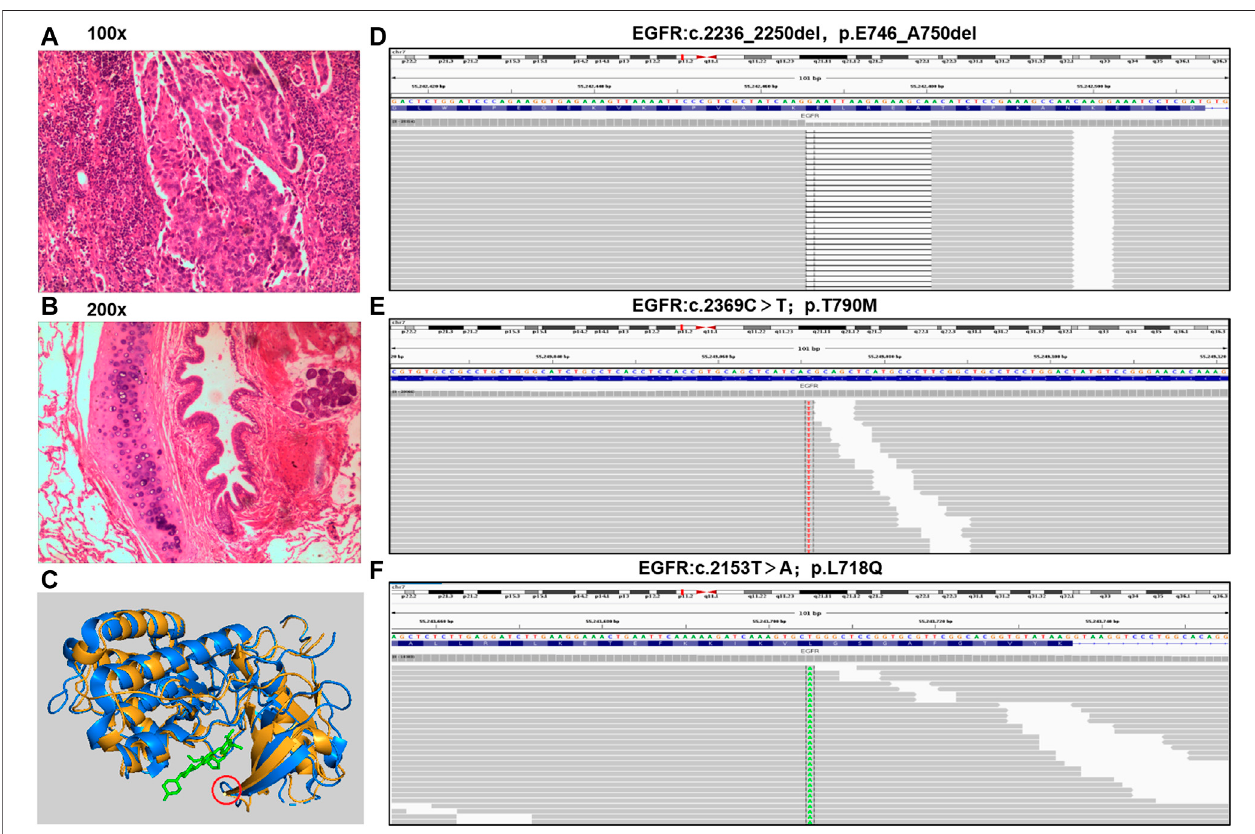
FIGURE 1 | Pathological diagnosis and molecular diagnosis. (A,B) , tumor specimen was applied to apex of right lung with a pathological diagnosis of lung adenocarcinoma(hematoxylin-eosinstaining:100xand 200x). (C) ,Three-dimensionalstructure ofEGFRproteinwithL718Qmutationpredicted byMODELLER.Yellow represent structure of EGFR T790M, blue represent EGFR L718Q mutation, green represent TKI, and red circle present site of L718Q mutation. (D – F) , the mutations of EGFR were analyzed through NGS in a laboratory accredited by the College of American Pathologists (CAP) and Clinical Laboratory Improvement Amendment (CLIA) (3D Medicines Inc., Shanghai,